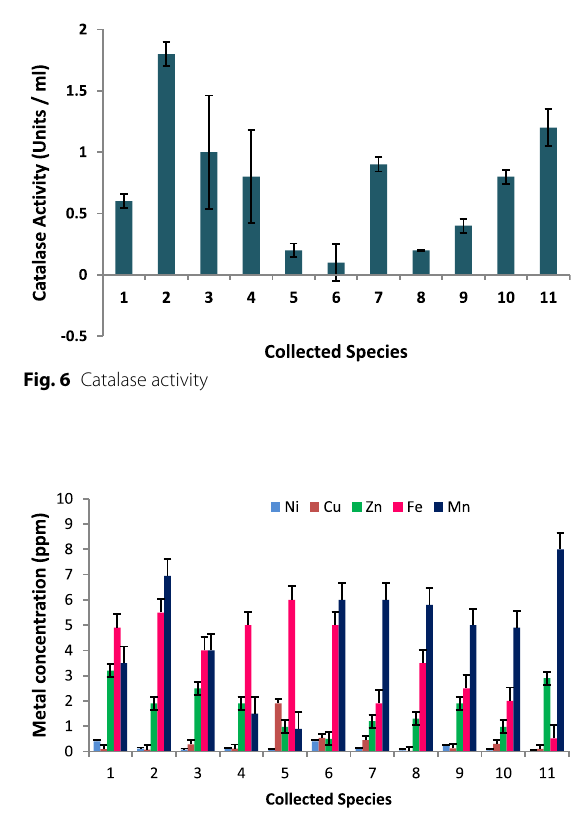
Fig. 7 Heavy metal studies in the collected fish